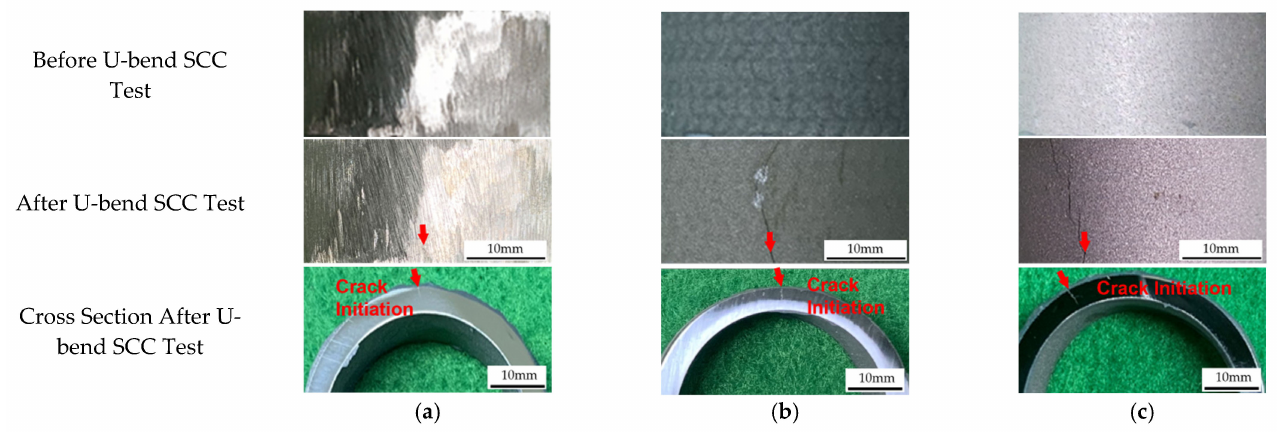
Figure 3. Surface appearance of 304LB by laser shock peening: ( a ) 304LB; ( b ) 304LB − L − NC; ( c ) 304LB − L −